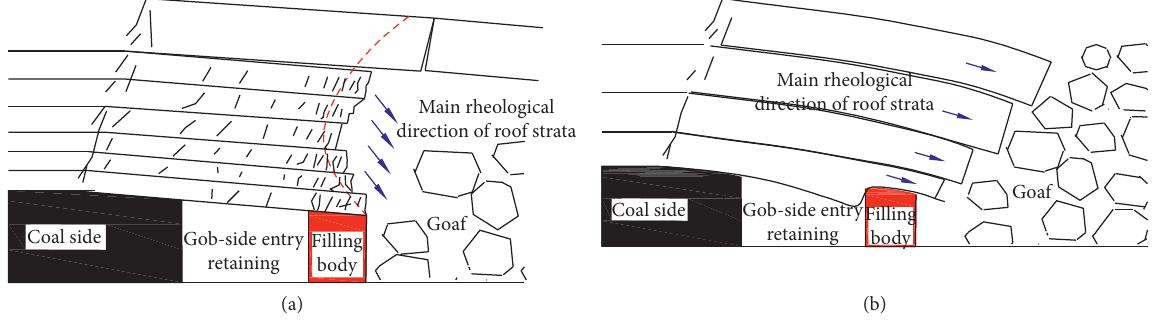
Figure 6: Failure types of the roof in the filling area. (a) Loose fractured roof and (b) rheoextrusion roof.